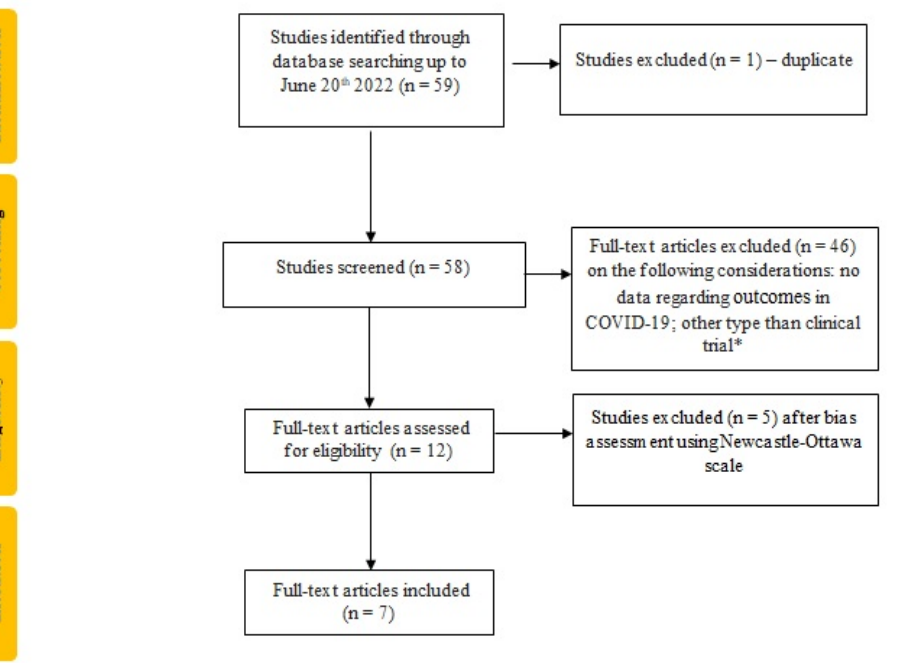
Figure 1. Flowchart of the study selection process. Flowchart of the study selection process according to PRISMA guidelines.